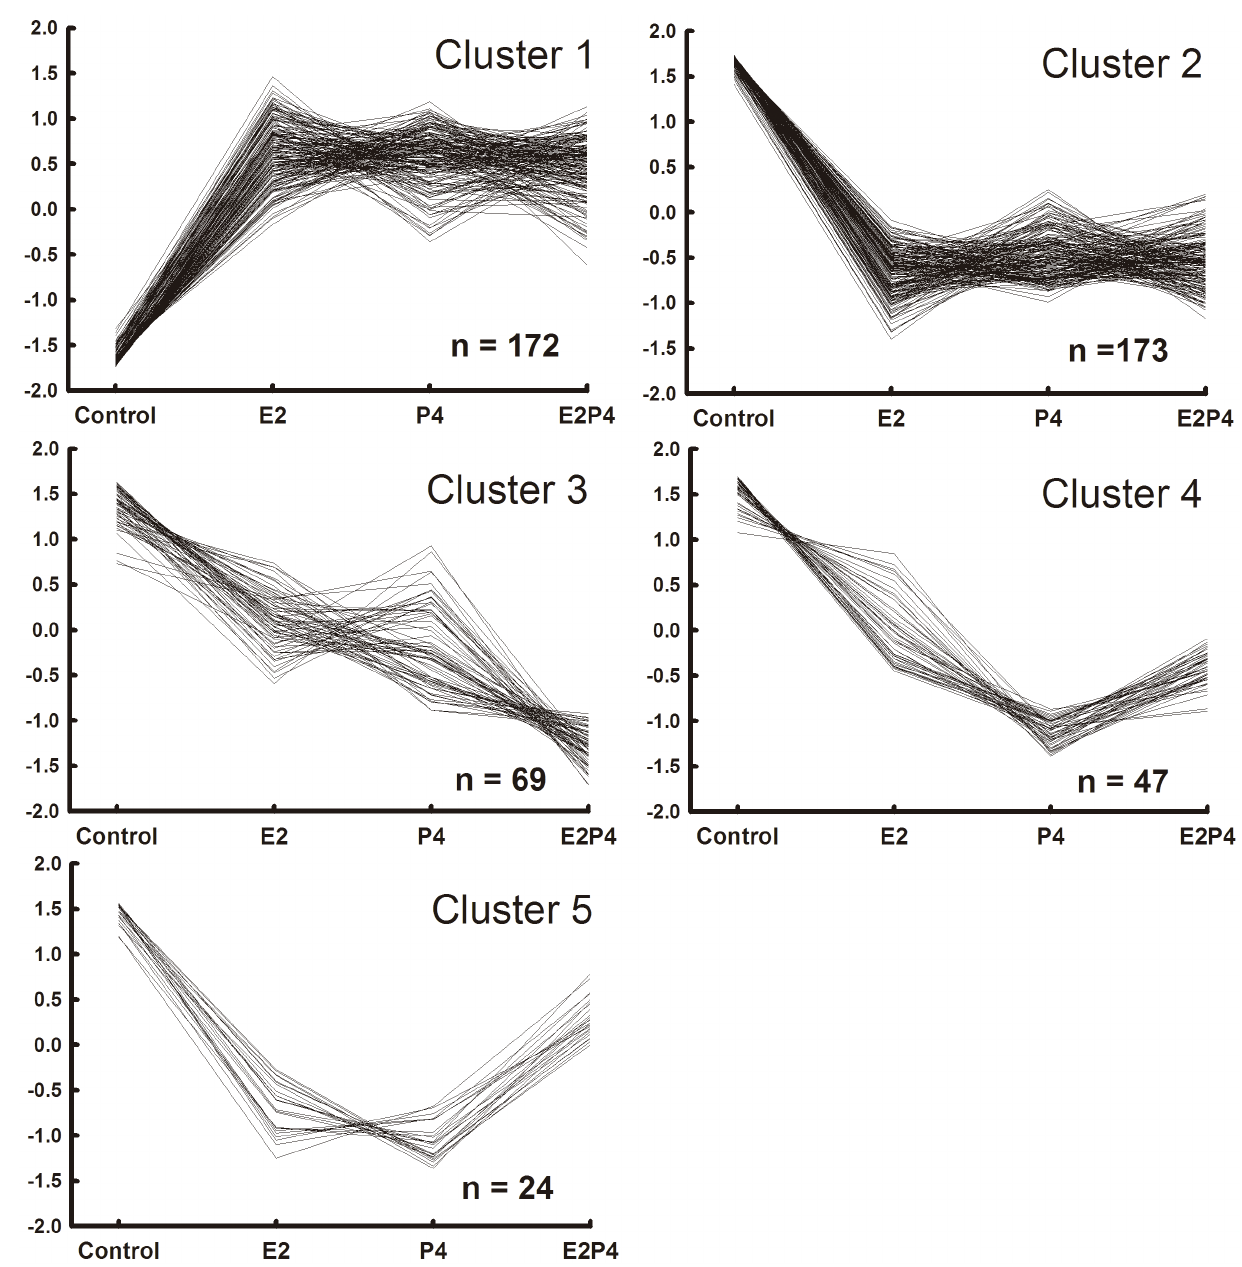
Figure 4. Hierarchical clustering analysis of significant genes by treatment. Unsupervised hierarchical clustering analysis produced five main clusters. The clusters correspond to upregulated genes in all treatments (Cluster 1, n=172), downregulated genes in all treatments (Cluster 2, n=173), synergized downregulated genes (Cluster 3, n=69), marked P4 downregulated genes that were moderately downregulated by estradiol-17 b and estradiol-17 b + progesterone (Cluster 4, n=47), and genes that were downregulated by estradiol-17 b and progesterone alone and antagonized by the combined treatment (Cluster 5, n=24). An extensive similarity of magnitude and direction of expression can be observed between significantly regulated